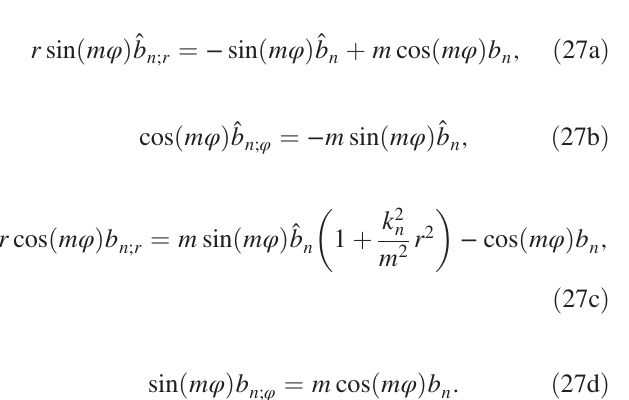
FIG. 2. Thick lines: Longitudinal B φ -field distribution in the midplane of a quadrupole at horizontal off-axis distances of r 0 ¼ 3 , 9, and 18 mm; thin lines: enhanced residuals (same color coding) between the RADIA field and a Fourier representation with 25